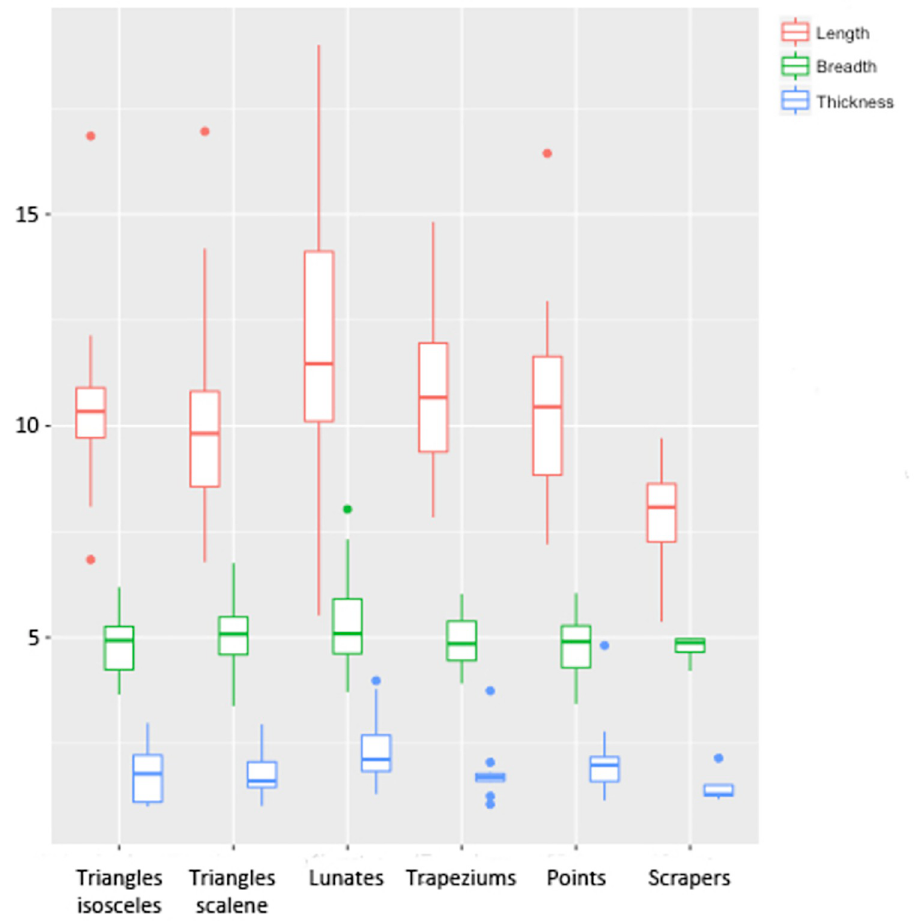
Fig 4. Boxplot showing the length, breadth and thickness (in mm) of the geometric and non-geometric tools from Vaharvo Timbo.